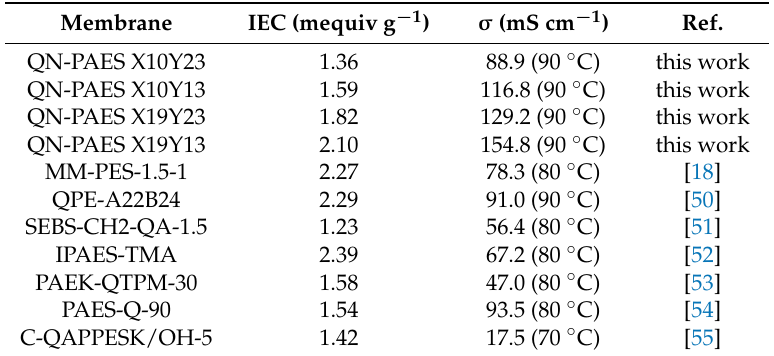
Figure 10. Hydroxide conductivity as a function of calculated IEC values’ comparison between recently reported AEMs.